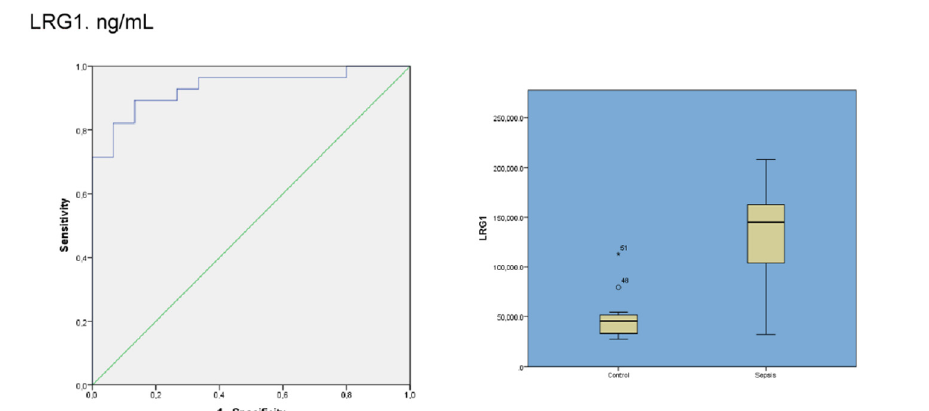
Figure 3. Area under the receiver operating characteristic (AUROC) and box plot for SAA-1, sCD25 and LRG1. Among these proteins studied as potential biomarkers, SAA-1 (AUROC 0.978; 95% CI: 0.946–1), sCD25 (0.97; 95% CI: 0.92–1) and LRG1 (0.93; 95% CI: 0.86–1), showed an area under the ROC curve greater than 0.9.